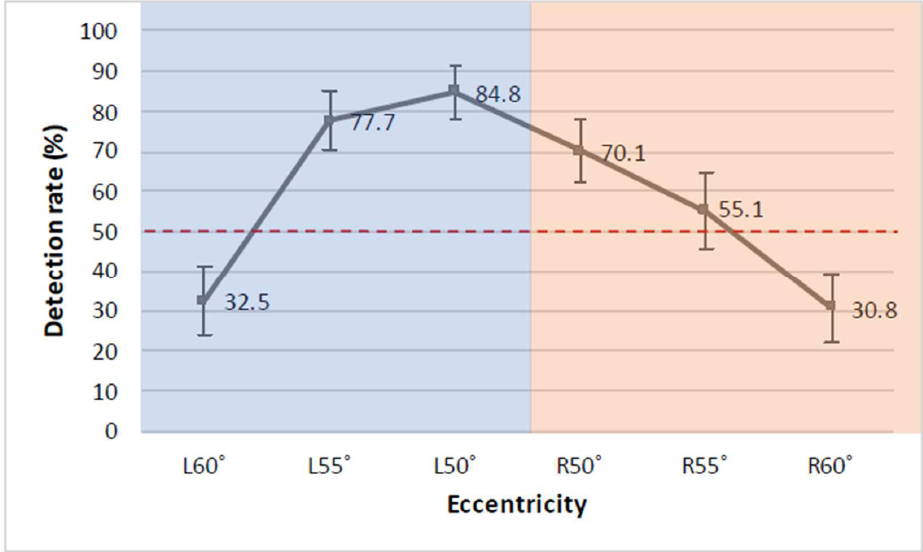
Figure 2. The detection rates of face-like targets across eccentricities in the left (blue) and right (orange) hemifields. Error bars represent +/− 1 SE.